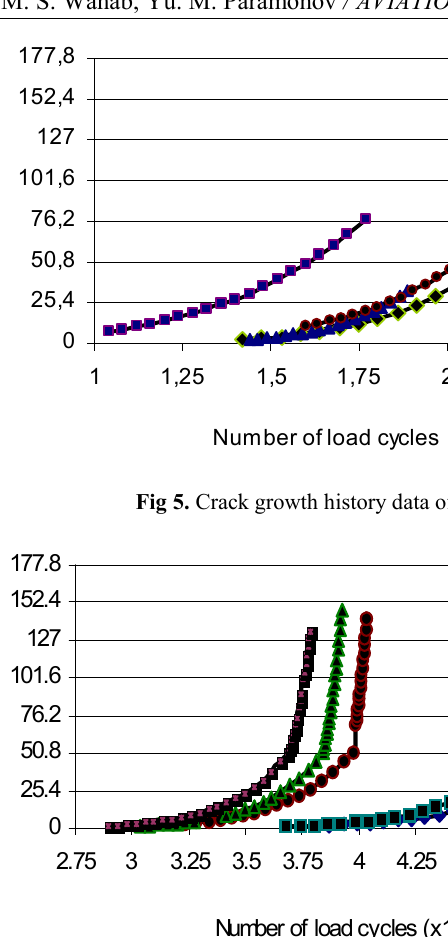
Fig 6. Crack growth history data of non-corroded